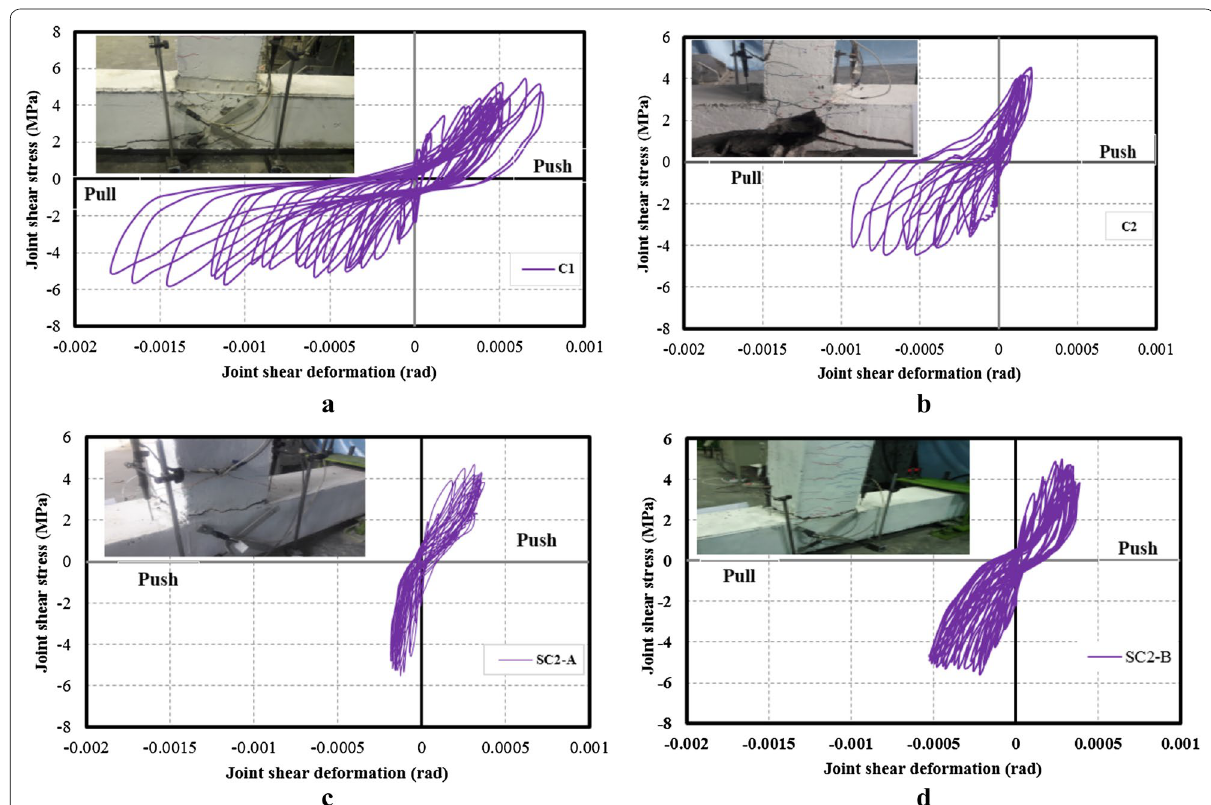
Fig. 27 Shear stress response versus deformation in joint specimens: a C1 Specimen; b C2 Specimen; c HPFRCC Specimen SC2-A; d HPFRCC Specimen SC2-B.